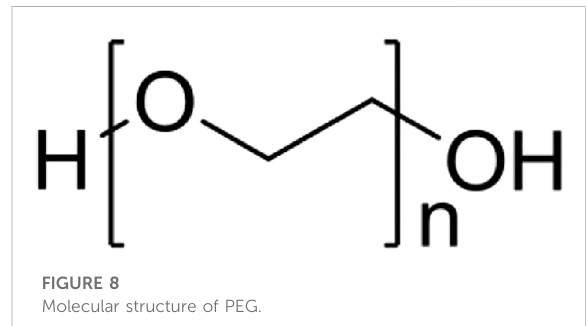
Molecular structure of